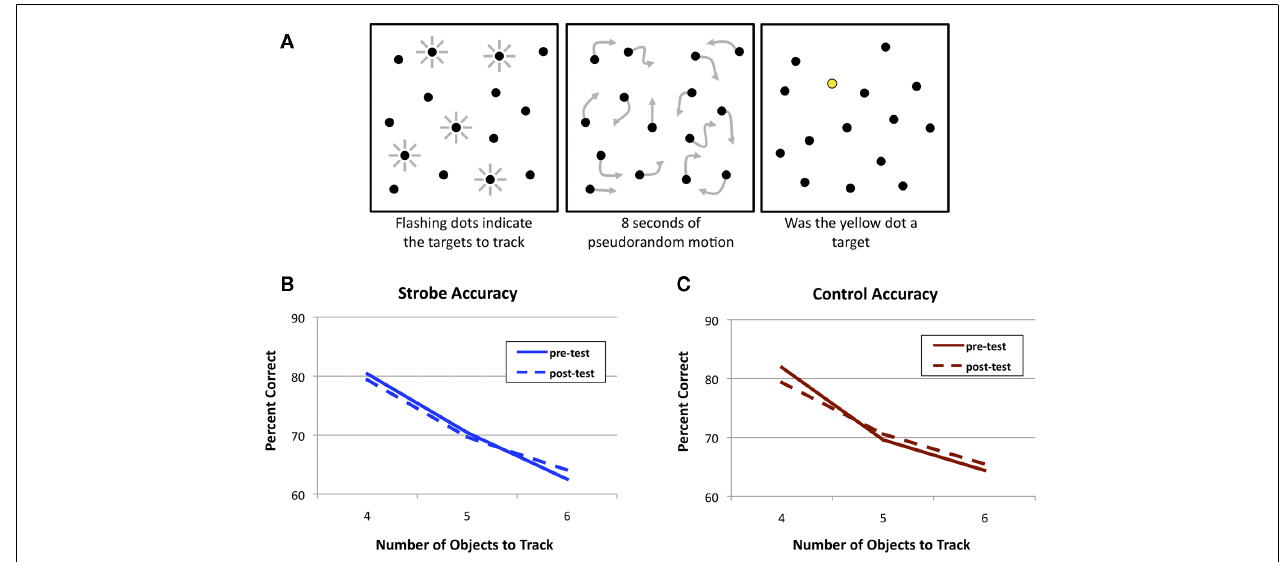
of objects to be tracked. (B) Strobe and (C) Control accuracy is shown as a function of the number of items tracked for the pre-test (solid) and post-test (dashed). No differences between pre- and post-test accuracy were observed for either training